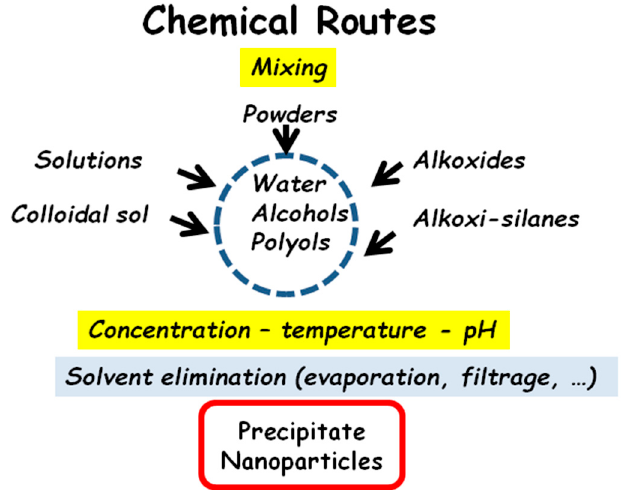
Figure 1. Schema of the different chemical routes.